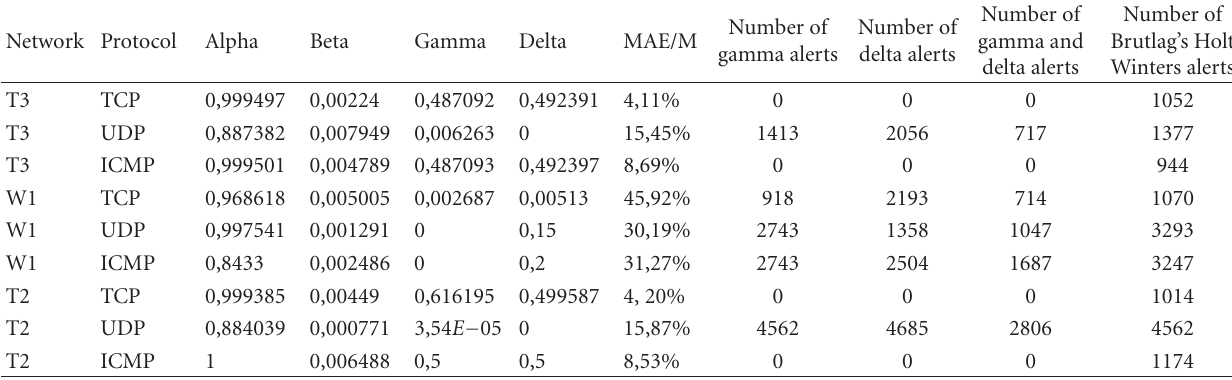
Table 1: Parameters of the HWT2 model for particular types of tra ffi